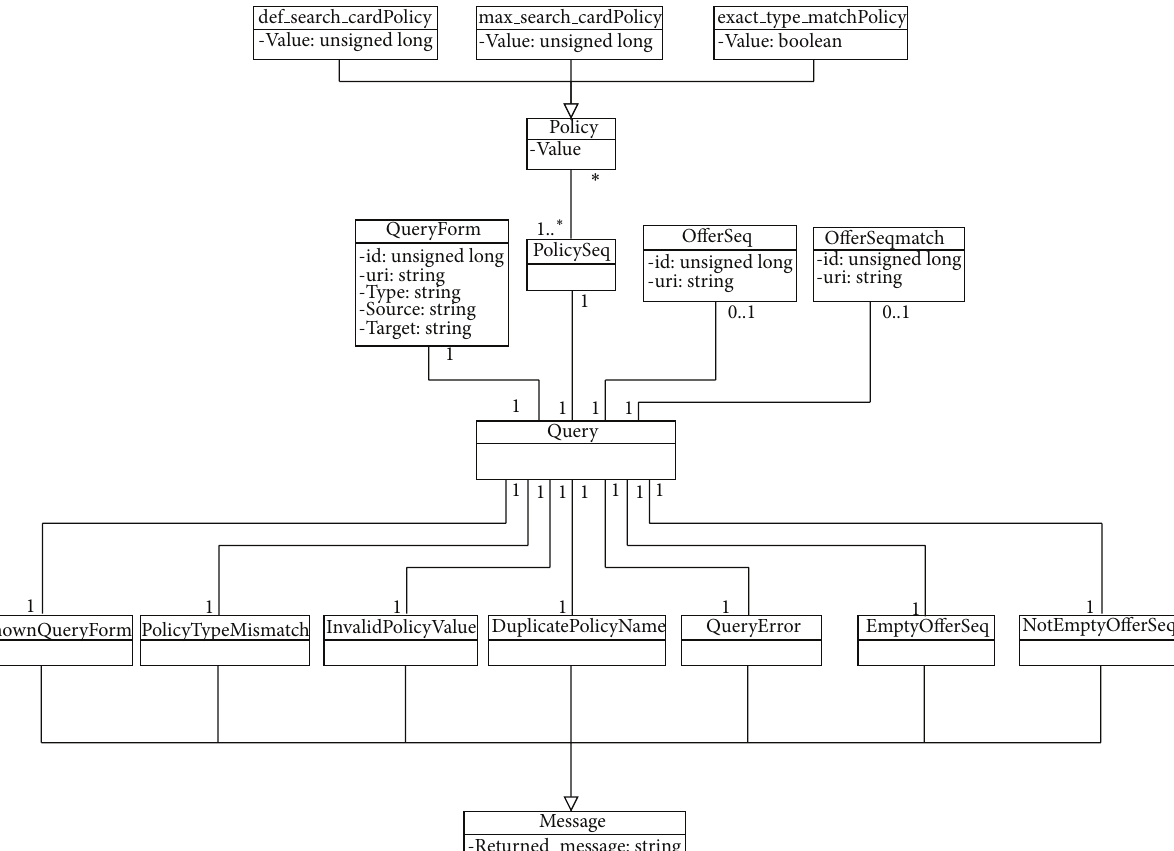
Figure 7: UML Lookup ontology